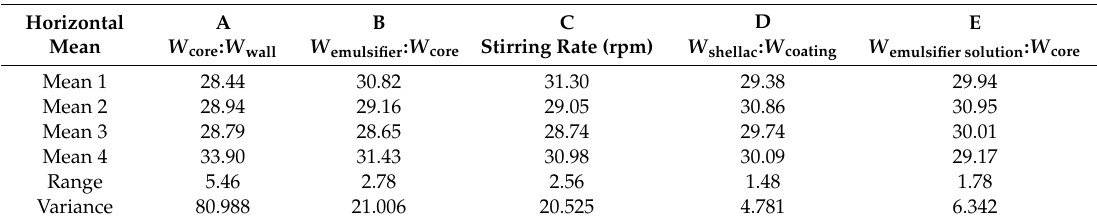
Table 4. Range and variance results of the output in the orthogonal experiment.